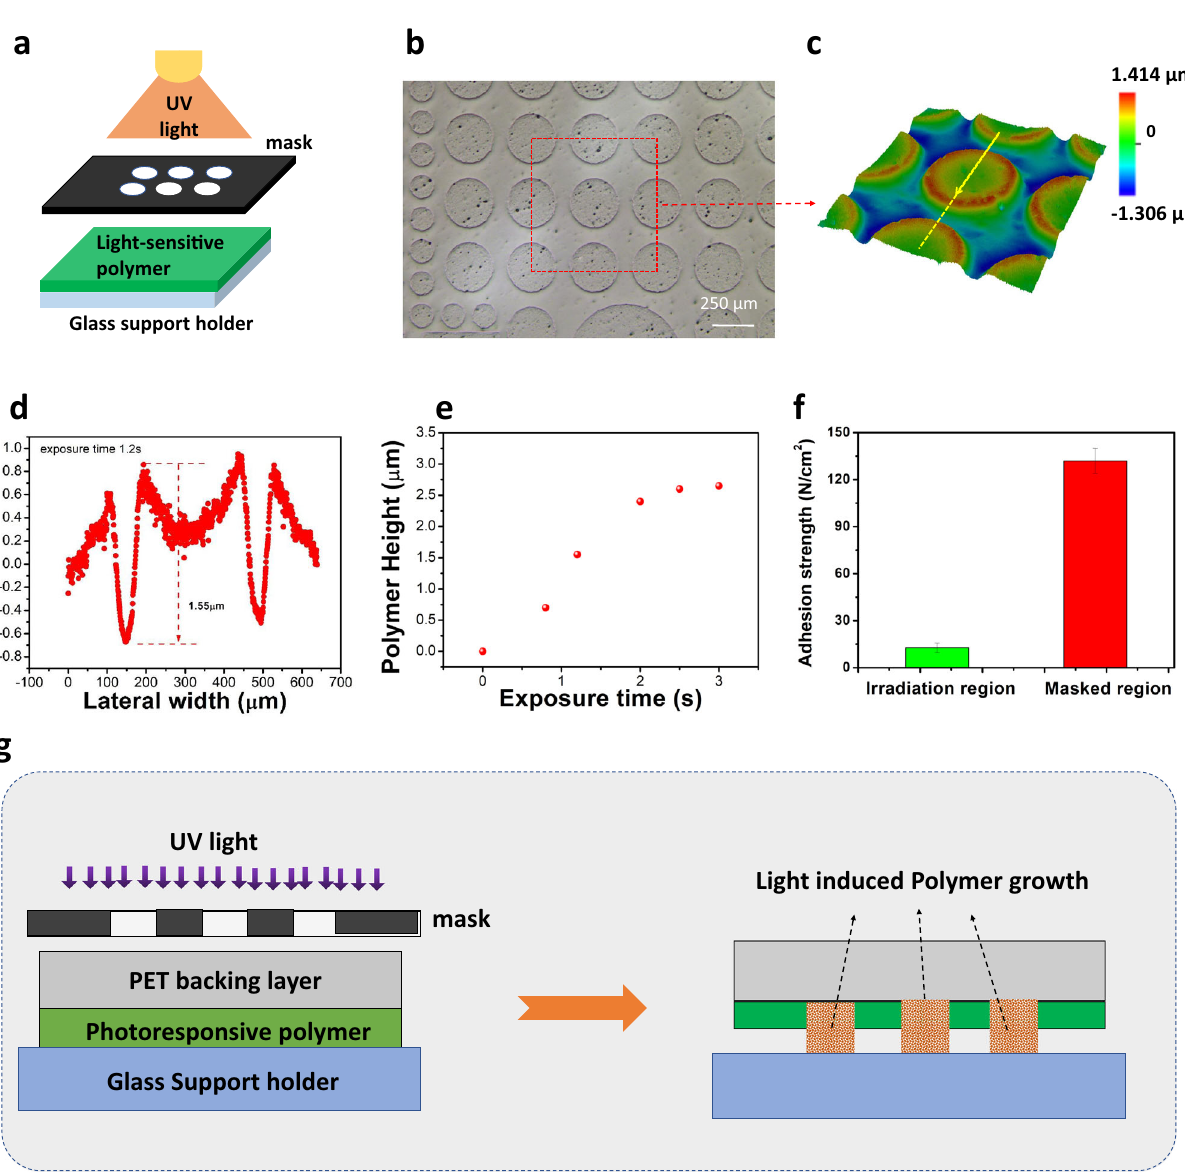
Fig. 2 Mask-de fi ned adhesion switching and polymer growth of the photosensitive polymer. a Schematic of the mask-de fi ned irradiation applied to the light-sensitive polymer. b Optical image of the photosensitive polymer after 1.2 s UV irradiation using a photomask, showing the increased polymer thickness at the exposure area. c Laser confocal 3D image of the polymer surface corresponding to the area marked by the red square in ( b ). d Cross-sectional pro fi le of the polymer surface under 1.2 s UV irradiation, scanning along the yellow arrow marked in ( c ). e polymer height as a function of the UV exposure time. f Measured adhesion strengths at the exposure area, and masked area. The exposure time is 2.5 s. g Schematic of the light-induced polymer